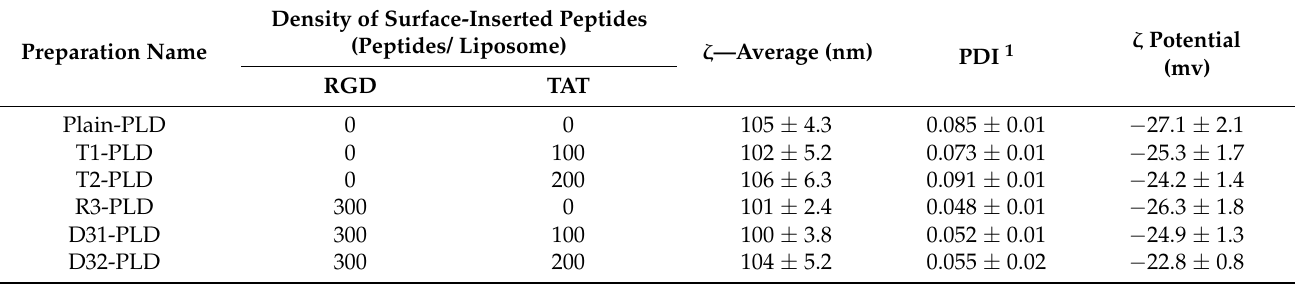
Table 1. Description and colloidal properties of